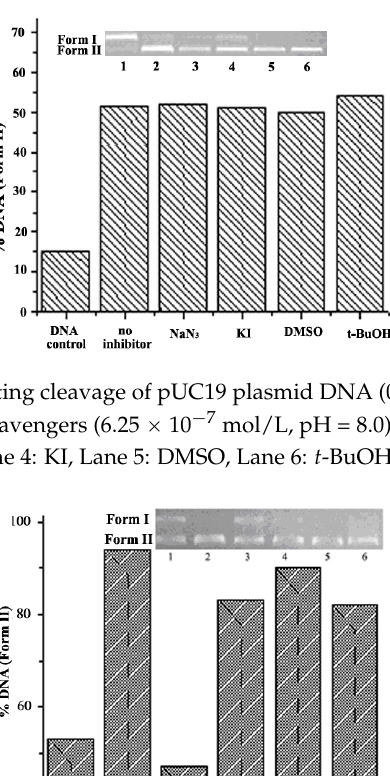
Figure 10. Histograms representing cleavage of pUC19 plasmid DNA (0.008 µg/µL) by compound 2a typical radical scavengers (6.25 × 10 − 7 mol/L, pH = 7.4). Lane 1: DNA control, Lane 2: no inhibitor, Lane 3: NaN 3 , Lane 4: KI, Lane 5: DMSO, Lane 6: t -BuOH.